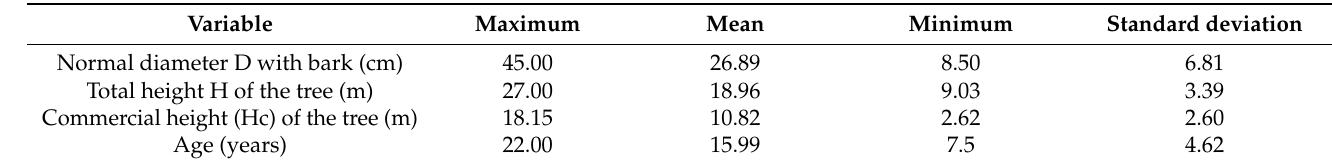
Table 1. Descriptive statistics of trees from the sample for tapering.